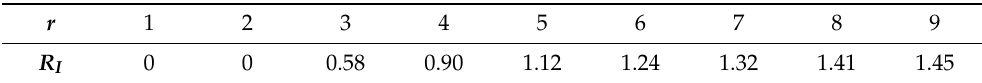
Table 3. The value of R I